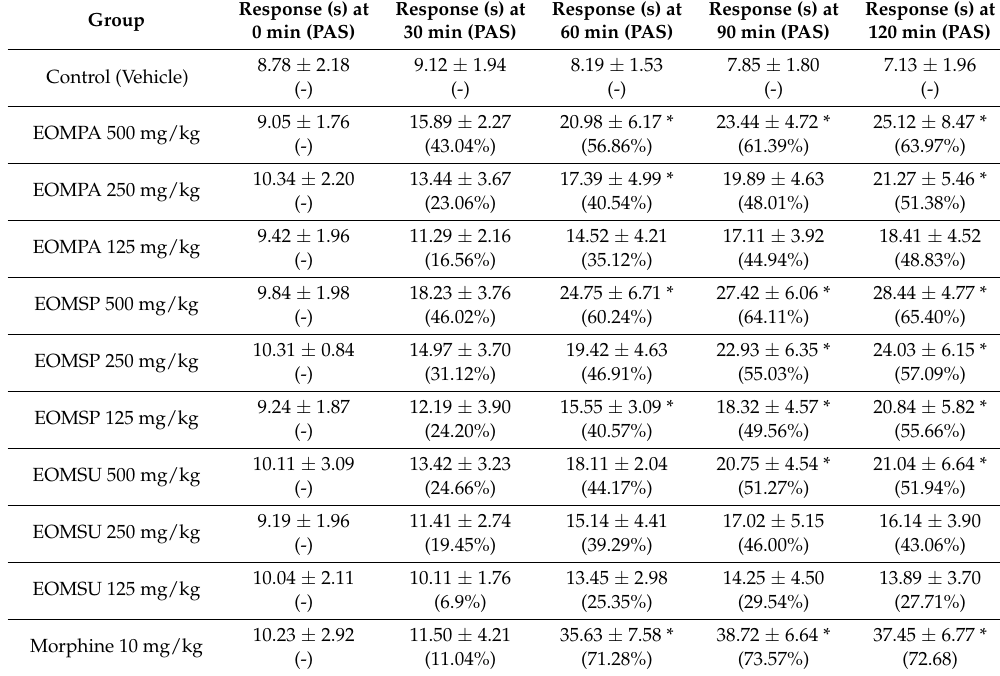
Table 4. Effect of the essential oils from the selected Mentha species in the hot plate test in mice.